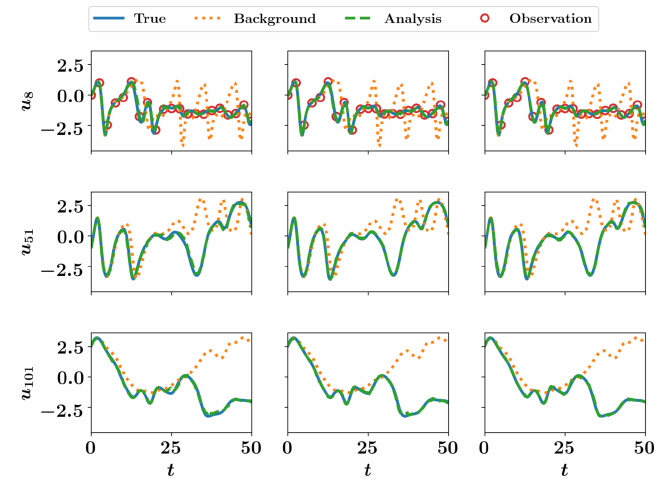
Figure 11. Selected trajectories of the Kuramoto–Sivashinsky model ( ν = 1/2) with the analysis performed by the ensemble Kalman filter (EnKF) using observations from m = 16 ( left ), m = 32 ( middle ), and m = 64 ( right ) state variables at every 10 time